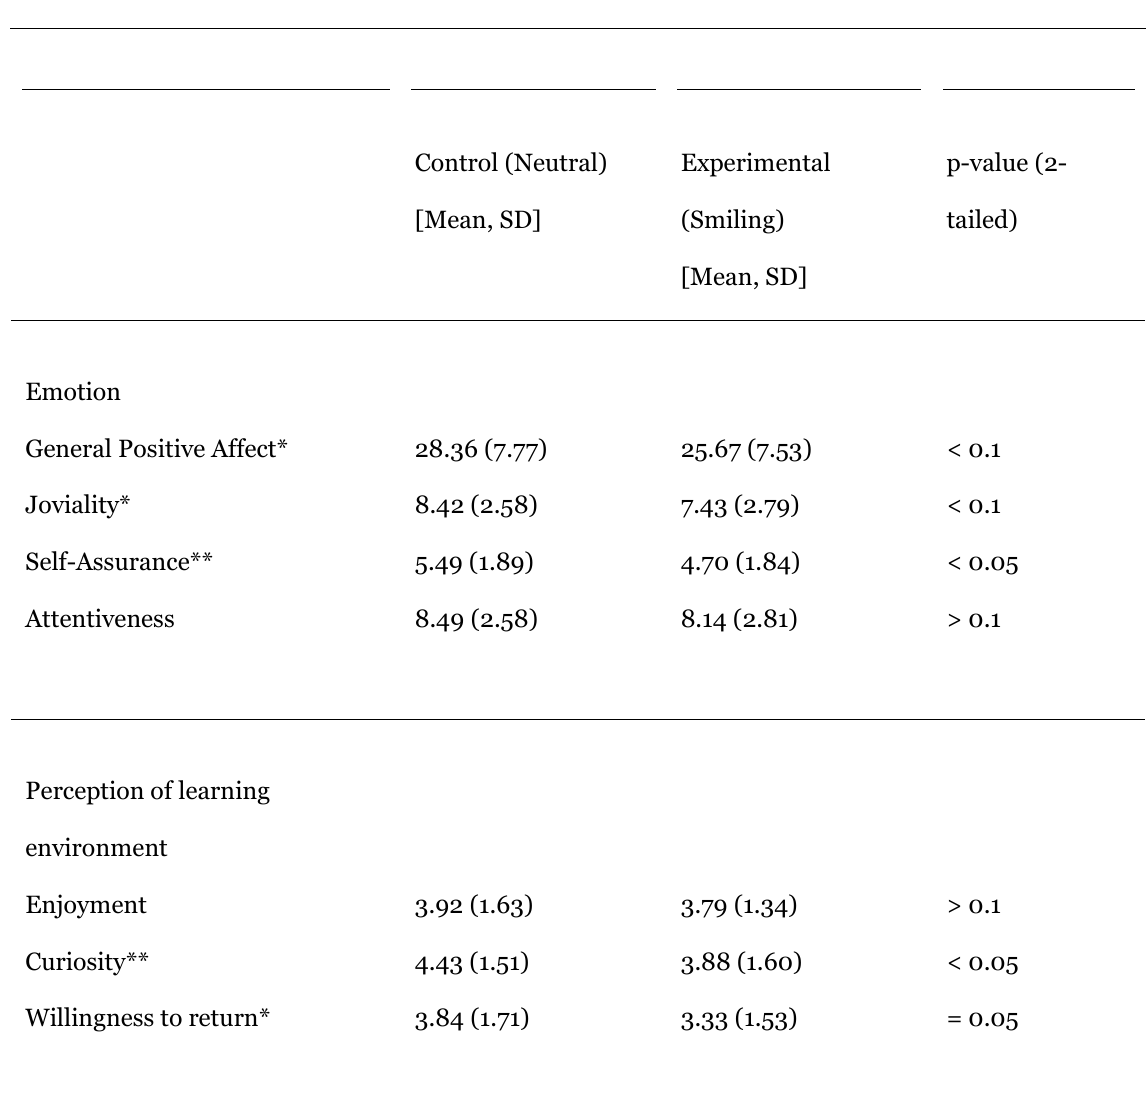
Means, Standard Deviations and p-values of t-test